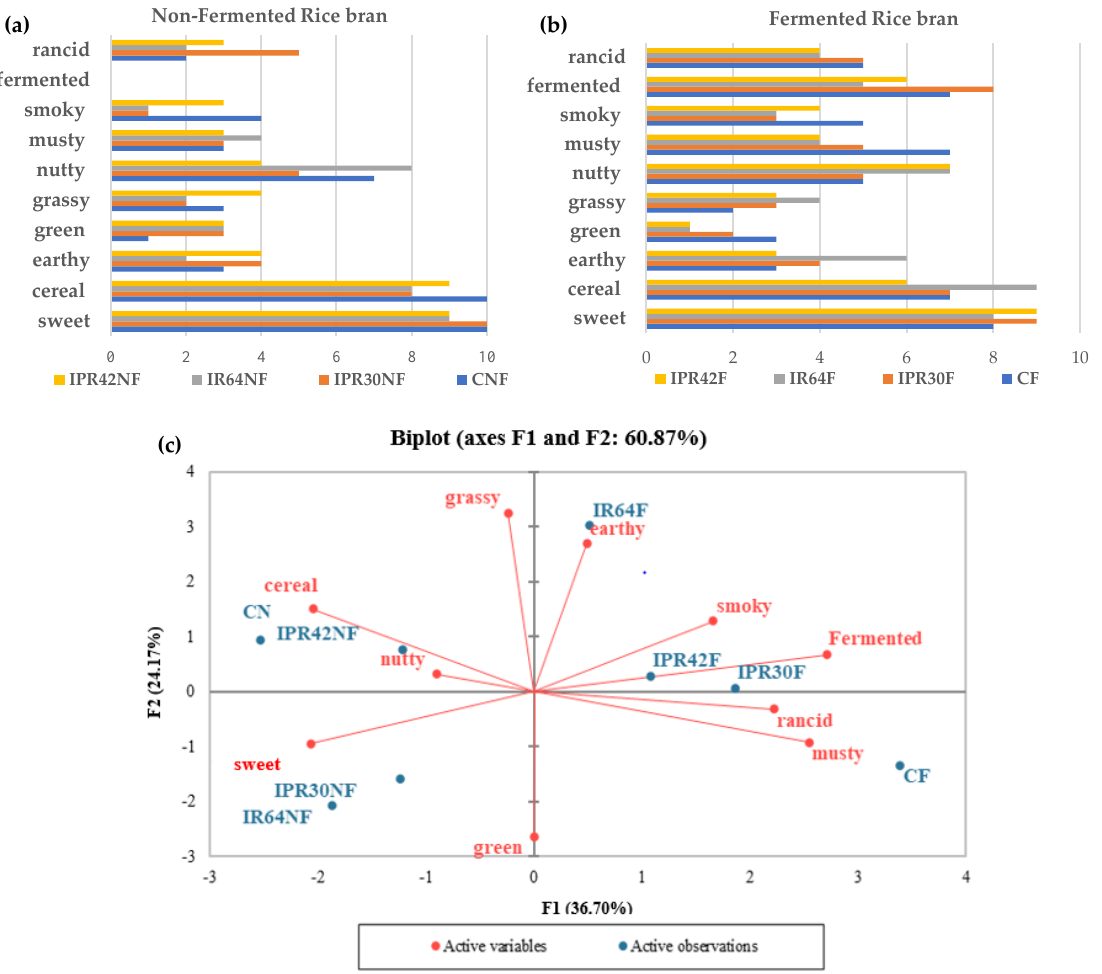
Figure 3. PCA of aroma description: ( a ) Ciherang nonfermented (CNF), Inpari42 nonfermented (IPR42NF), Inpari30 nonfermented (IPR30NF) and IR64 nonfermented (IR64NF) rice bran; ( b ) Ci- herang fermented (CF), Inpari42 fermented (IPR42F), Inpari30 fermented (IPR30F), IR64 fermented (IR64F) rice bran; ( c ) FRB and